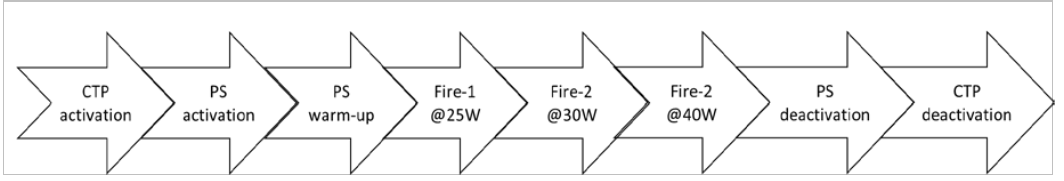
Figure 8. Environmental test sequence.